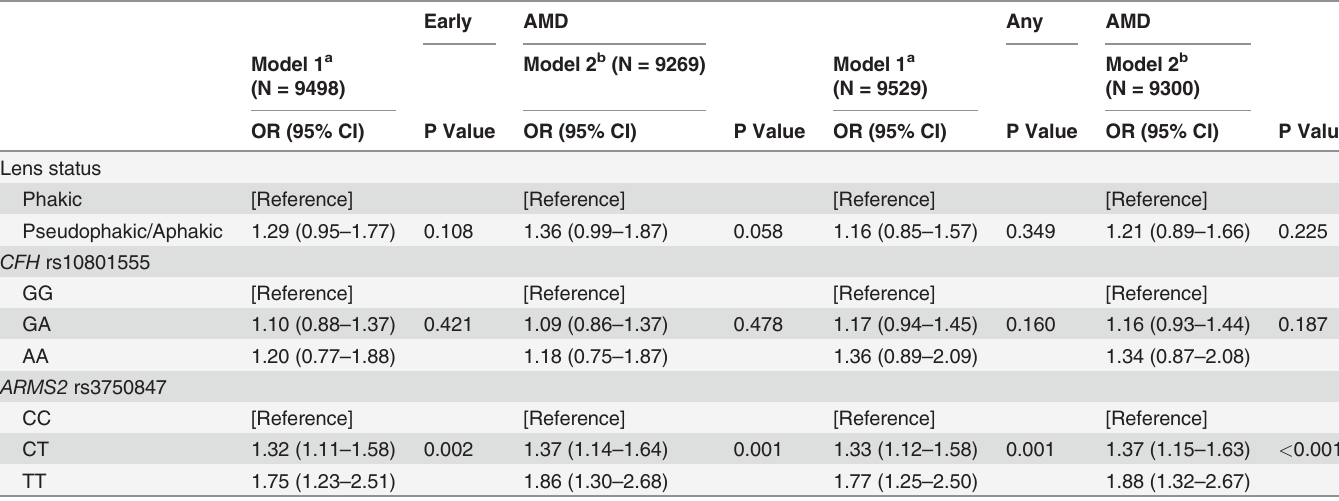
OR, odds ratio; CI, con fi dence interval. a Multivariate logistic regression using general estimating equations, adjusted for age, gender, and ethnicity for the effect of lens status, and additionally adjusted for the fi rst 5 genetic principal components for the effects of SNPs. b Adjusted for the covariates in Model 1 and current smoker, hypertension, diabetes, hyperlipidaemia, and chronic kidney